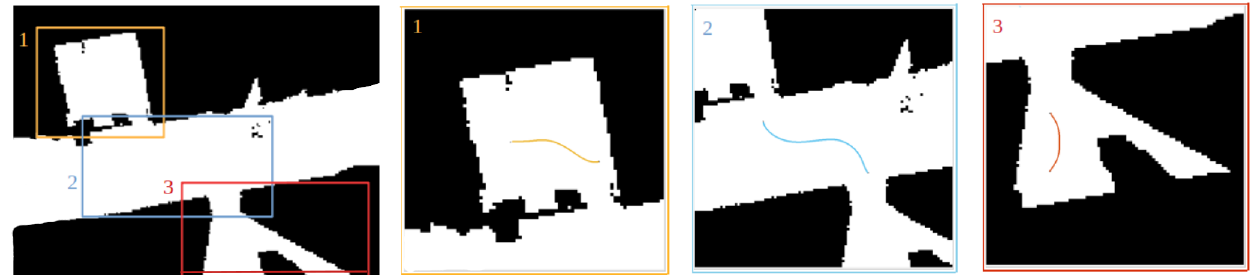
Figure 21. Calculated local geometric paths. The robot is located in room 1 and it needs to reach room 3, so a path in room 2 is also computed to connect both locations.